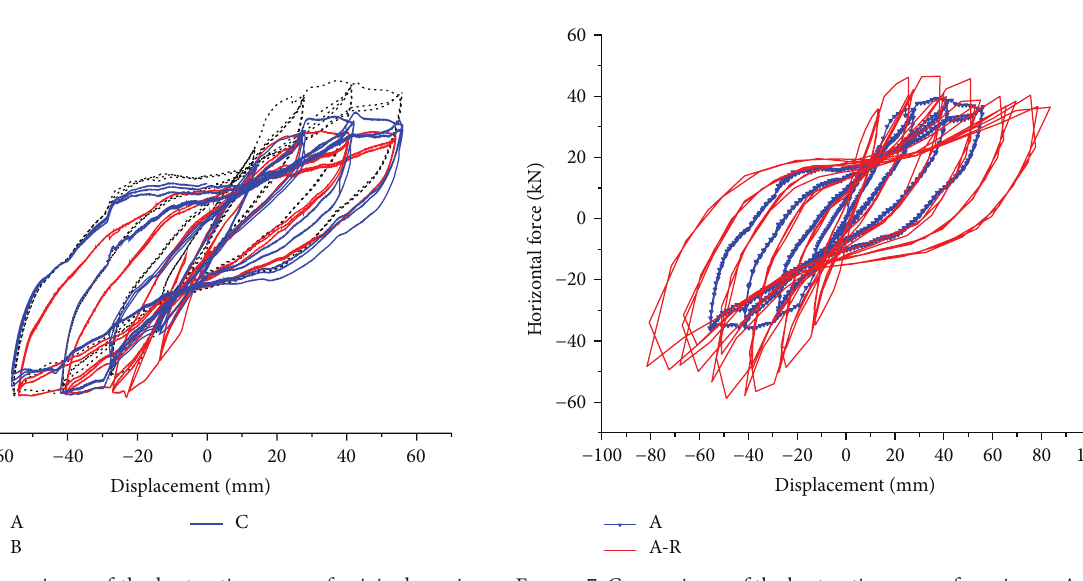
Figure 7: Comparisons of the hysteretic curves of specimens A and